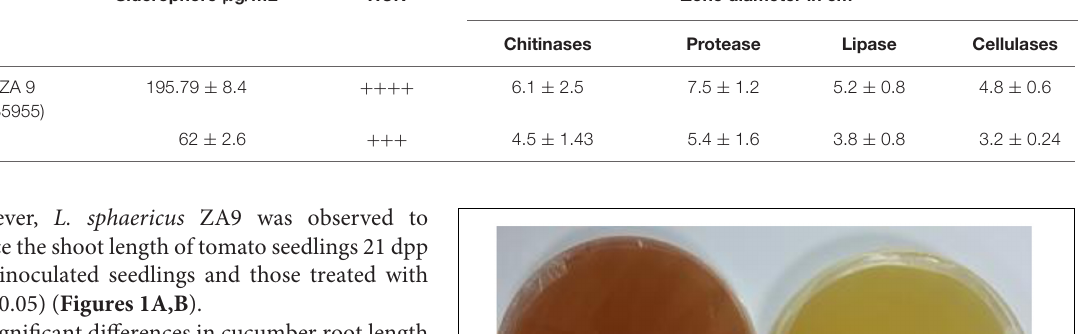
TABLE 3 | Production of secondary metabolites and hydrolytic enzymes by Lysinibacillus sphaericus . Bacterial isolate